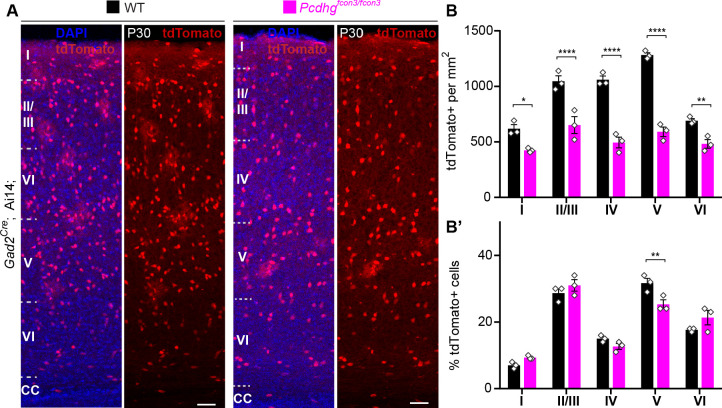
Reduced number of GABAergic cINs across cortical layers in Pcdhg-deficient mice.(A) Representative photographs of the primary visual cortex (V1) in Gad2Cre;Ai14;Pcdhg+/+ (Pcdhg WT) and Gad2Cre;Ai14;Pcdhgfcon3/fcon3 (Pcdhg mutant) mice. Sections stained for tdTomato and DAPI. Scale bars, 50 μm. (B) Quantification of tdTomato+ Gad2Cre-derived cINs in layers I-VI of visual cortex (V1) in Pcdhg WT (black bars) and Pcdhg mutant mice(magenta bars) (2-way ANOVA, Fgenotype = 244.83, P value<0.001; adjusted p values *p=0.02, **p=0.01, ***p<0.0001; n = 3 mice per genotype). (B’) Layer distribution of tdTomato+ Gad2Cre-derived cINs shown as percentage from total tdTomato+ cells in V1 of Pcdhg WT and Pcdhg mutant mice(2-way ANOVA, Fgenotype = 0.01, P value = 0.93, adjusted p values **p=0.01; n = 3 mice per genotype).
Figure 2—figure supplement 2—source data 1.Quantification of all GABAergic cINs by cortical layer in the visual cortex of controls and Pcdhg-deficient mice.